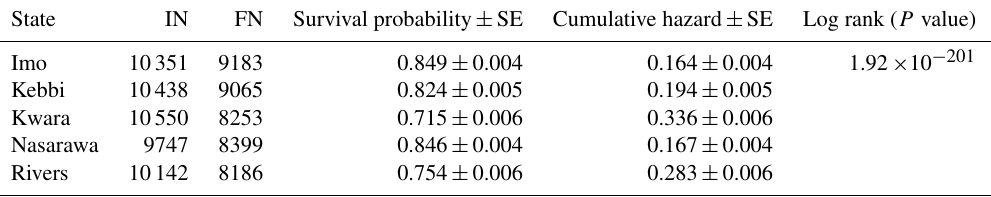
Table 9. Effect of agroecology on overall on-farm survival performance of birds (male and female) during growing phase in ACGG Nigeria project zones (6–18 weeks) (2016–2017).